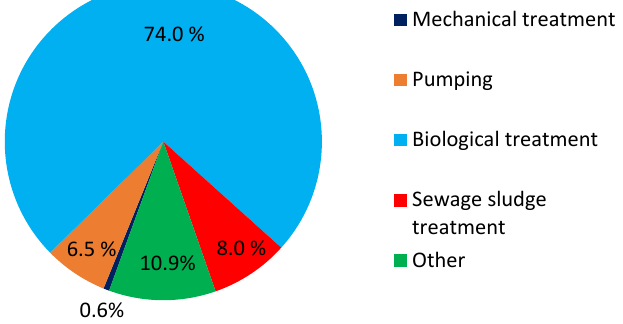
Figure 1. Electricity consumption in particular parts of a wastewater treatment plant (WWTP) located in southern Poland [based on authors’ own work ].